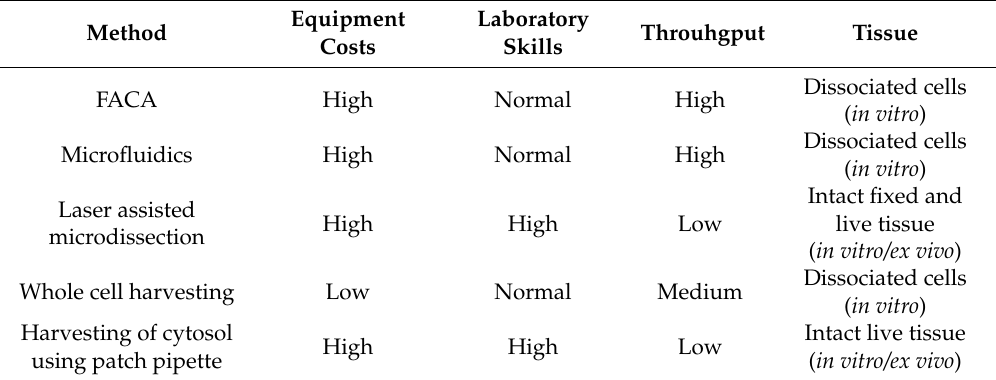
Table 1. Overview of different cell and cytosol harvesting